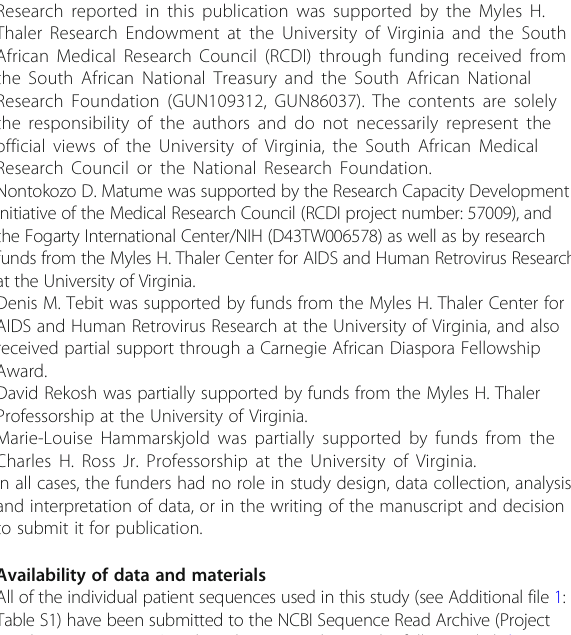
Additional file 4: Table S4. Apobec 3G- Linkage Disequilibrium Calculations: D ’ and R 2 values. (PDF 33 kb) Additional file 5: Table S5. Apobec 3H- Linkage Disequilibrium Calculations: D ’ and R 2 values. (PDF 50